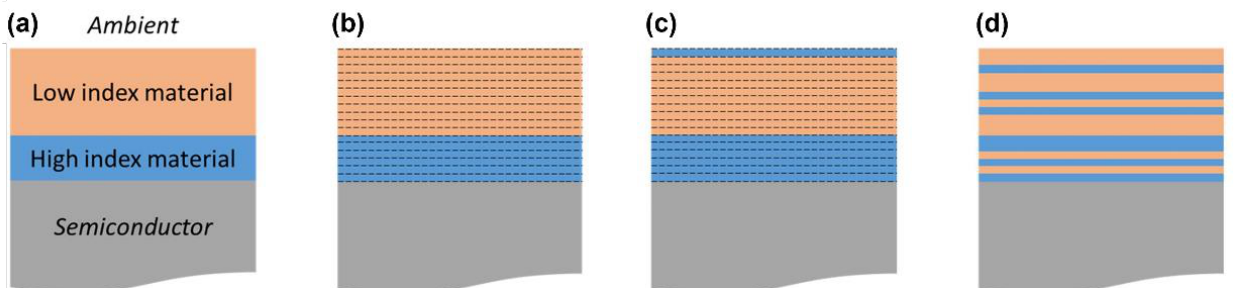
Figure 11. The design process of the HLIS film: ( a ) selecting the optimum thickness of the high and low refractive index materials, ( b ) cutting the DLARC into layers of equal thickness, ( c ) swapping one target layer at a time, and ( d ) forming the HLIS after several iterations. Reprinted with permission [33]; 2021, Elsevier.